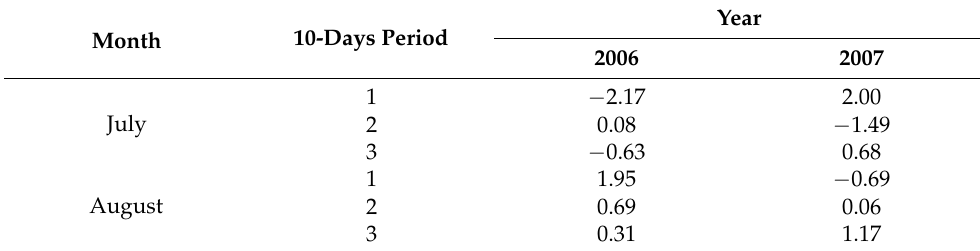
Table 6. Values of the Stenz index for the 2006–2007 irrigation